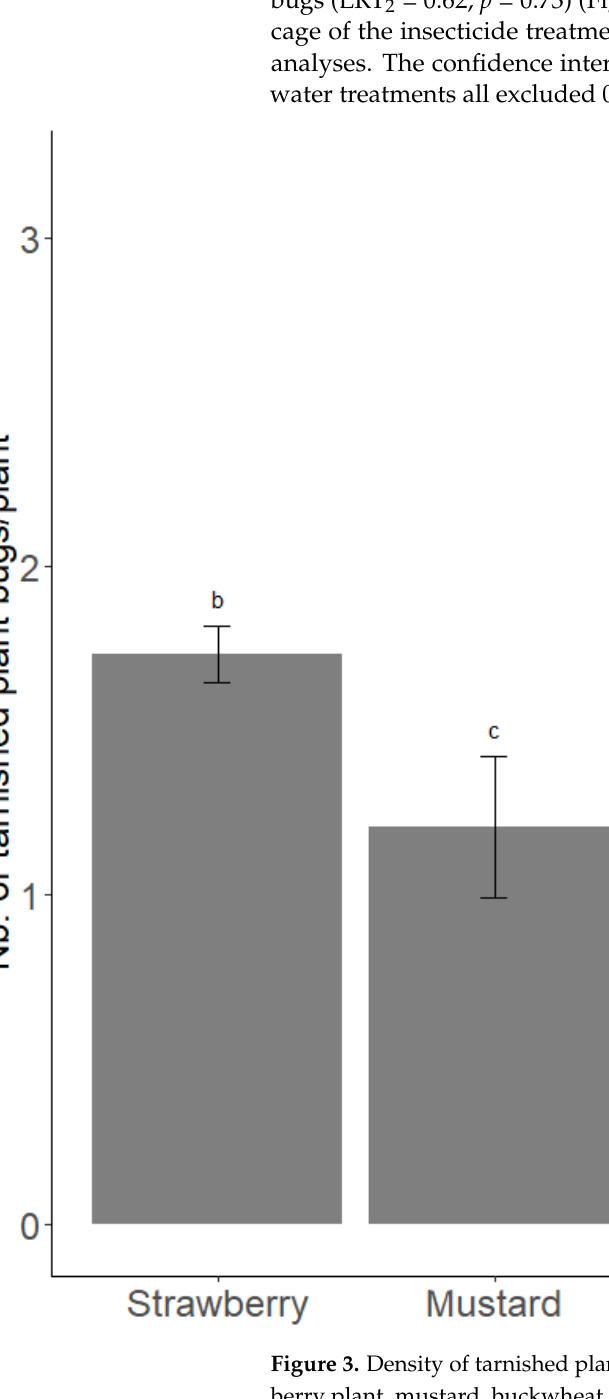
Figure 3. Density of tarnished plant bugs (all stage pooled) during period of peaks on hosts (straw- berry plant, mustard, buckwheat, and mullein) during 2016 and 2017. Estimated number of adult tarnished plant bugs during peak of population from beatings on strawberry, mustard, and buck- wheat during summer (in light grey) and on mullein during autumn (in dark grey) in 2016 and 2017. Error bars are 95% confidence intervals. Letters correspond to significant differences among treatments ( α =